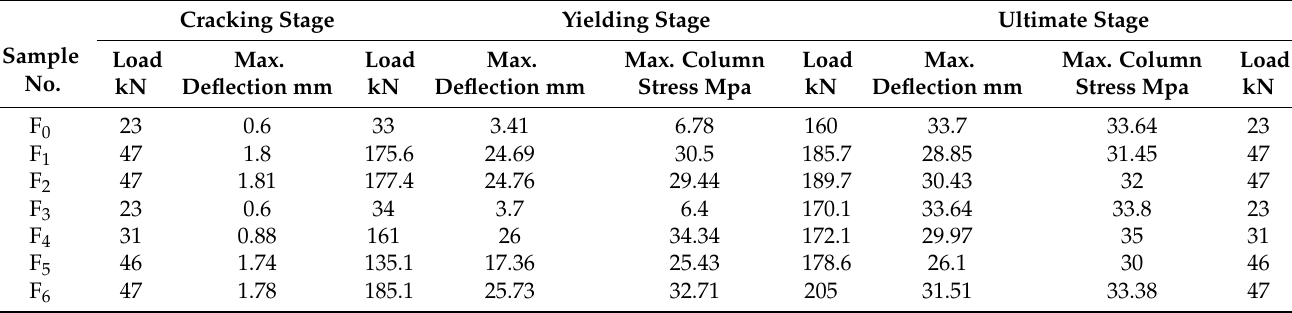
Table 2. Summary of the test results of all frame